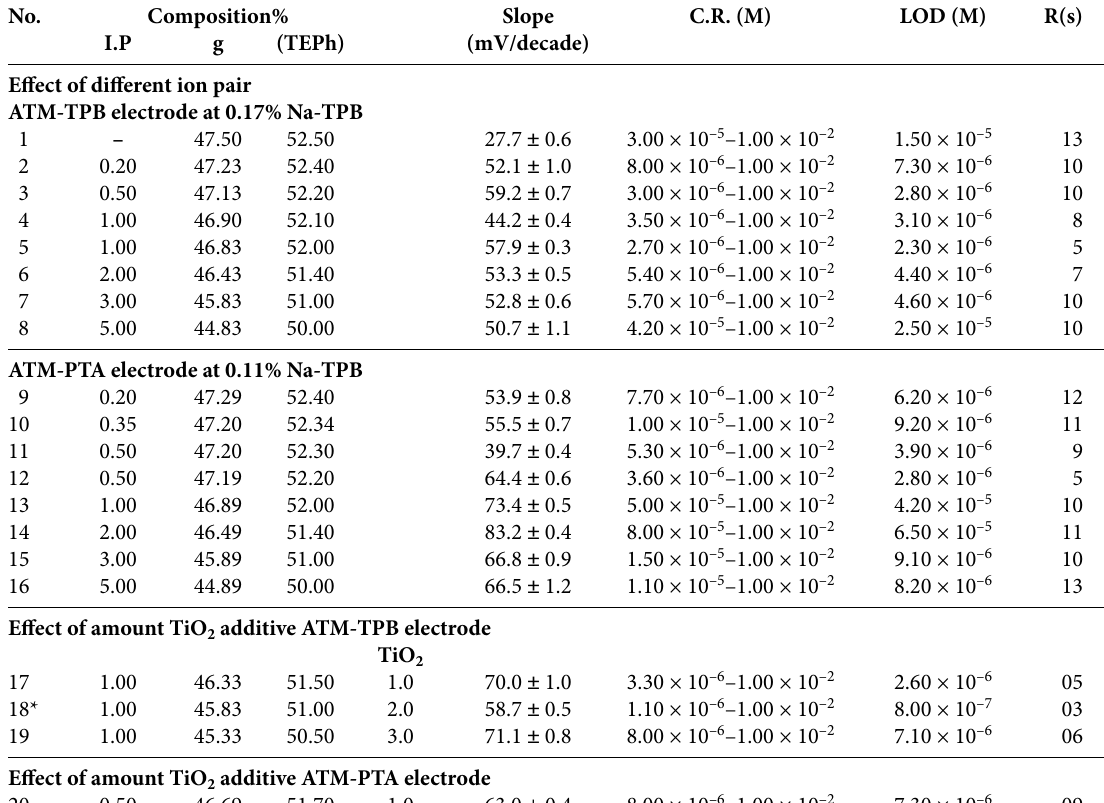
Table 1. Response characteristics of ATM-TPB and ATM-PTA electrodes at 0.90 g/p